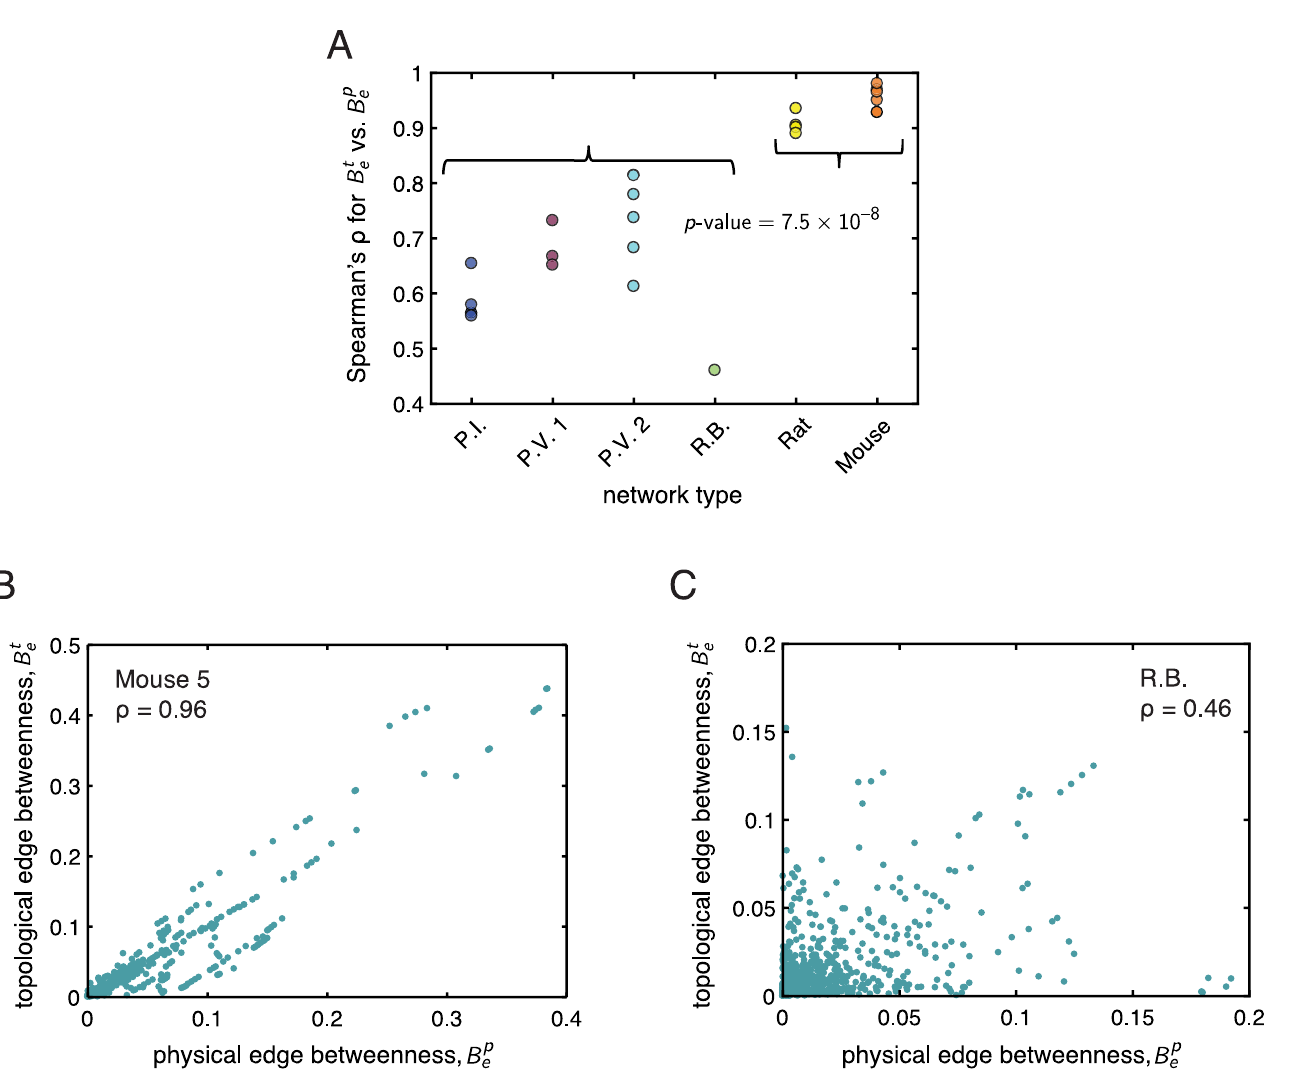
Fig 4. Topological vs. physical edge-betweenness centrality. (A) For each kind of network (displayed on the x -axis), the data shows the Spearman rank correlation coefficient ρ for the relationship between the topological edge betweenness centrality B t braces group the fungi (first 4 networks) and vasculature (last 2 networks). All networks exhibited significant positive rank correlations, but the displayed p -value from a two-sample t -test indicates that the mean rank correlation coefficient of the mycelial networks was significantly smaller than the mean rank correlation coefficient of the vasculature networks. (B) Topological edge betweenness centrality B t highest Spearman correlation between these quantities (Mouse 5). (C) Topological edge betweenness centrality B t the network with the lowest Spearman correlation between these quantities (R.B.). See the text for more details on these measures.